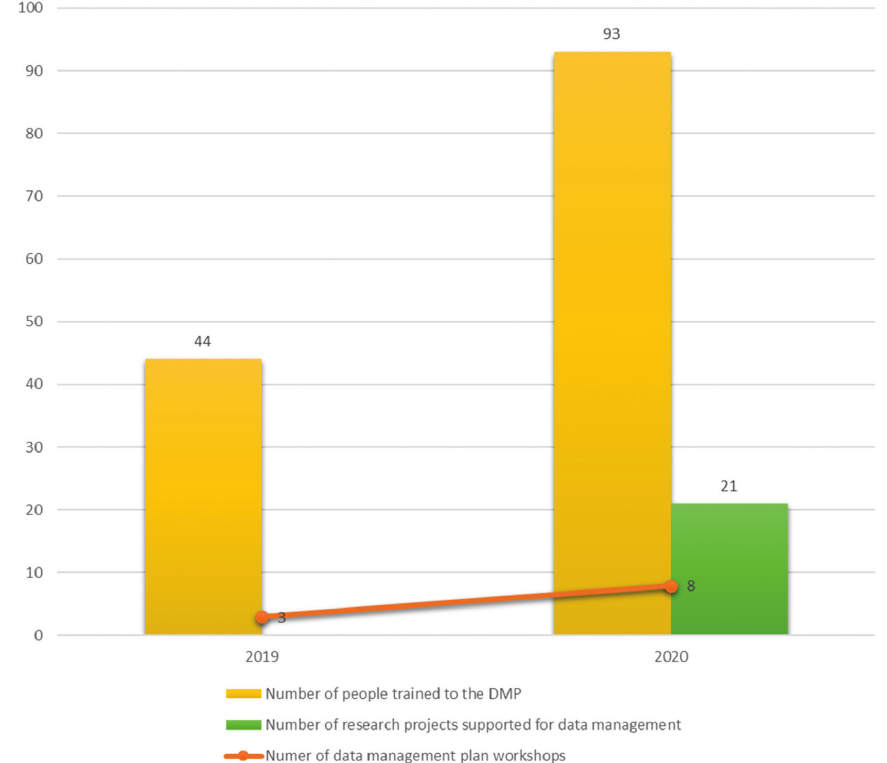
Fig. 9: Training and support for researchers on research data management